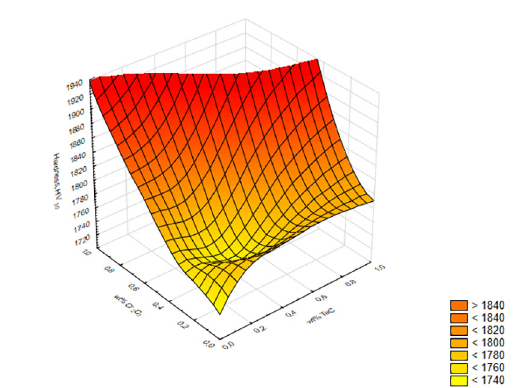
Figure 5. Hardness as function of additive contents of spark plasma sintered WC-6Co cemented carbides. Corresponding assay data are presented in Table 1.